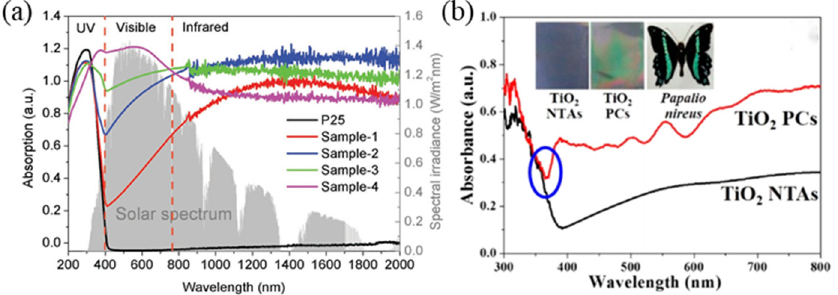
Figure 8. ( a ) Solar spectrum and UV–Vis–NIR absorption spectra of TiO x nanoparticles with different colors (Reprinted/adapted with permission from Ref. [63]. Copyright 2017, copyright Wiley-VCH). ( b ) UV-vis absorption spectra for TiO 2 NTAs and TiO 2 PCs and the optical photograph of the TiO 2 NTAs, TiO 2 PCs, and Papalio nireus (Reprinted/adapted with permission from Ref. [64]. Copyright 2018, copyright American Chemical Society).